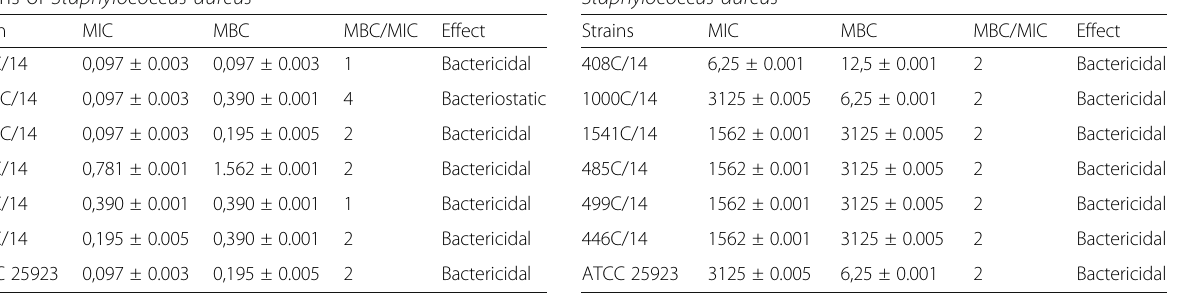
Table 4 Antibacterial activity of aqueous extract of Tieghemella heckelii on Methicillin- resistant and reference strains